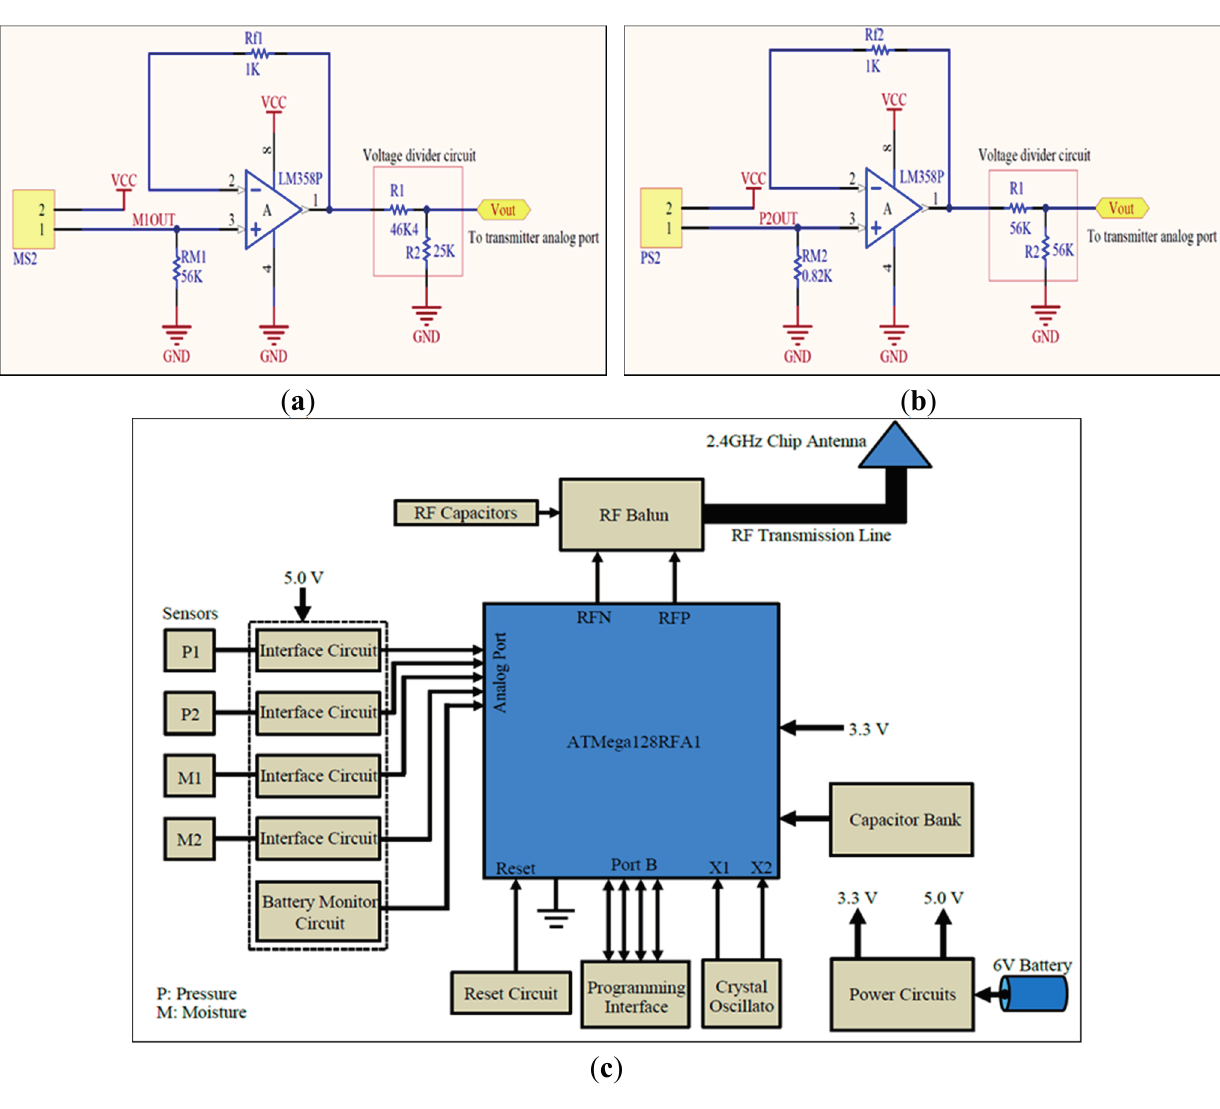
Figure 5. ( a ) Schematic of interface circuit for the moisture sensor HCZ-D5; ( b ) schematic of interface circuit for the pressure sensor FSR406; ( c ) block-level circuit schematic for RF telemetry device and its external